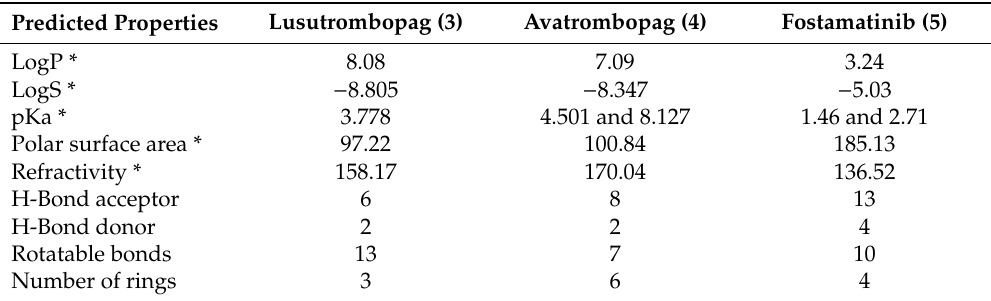
Table 2. Properties of the new